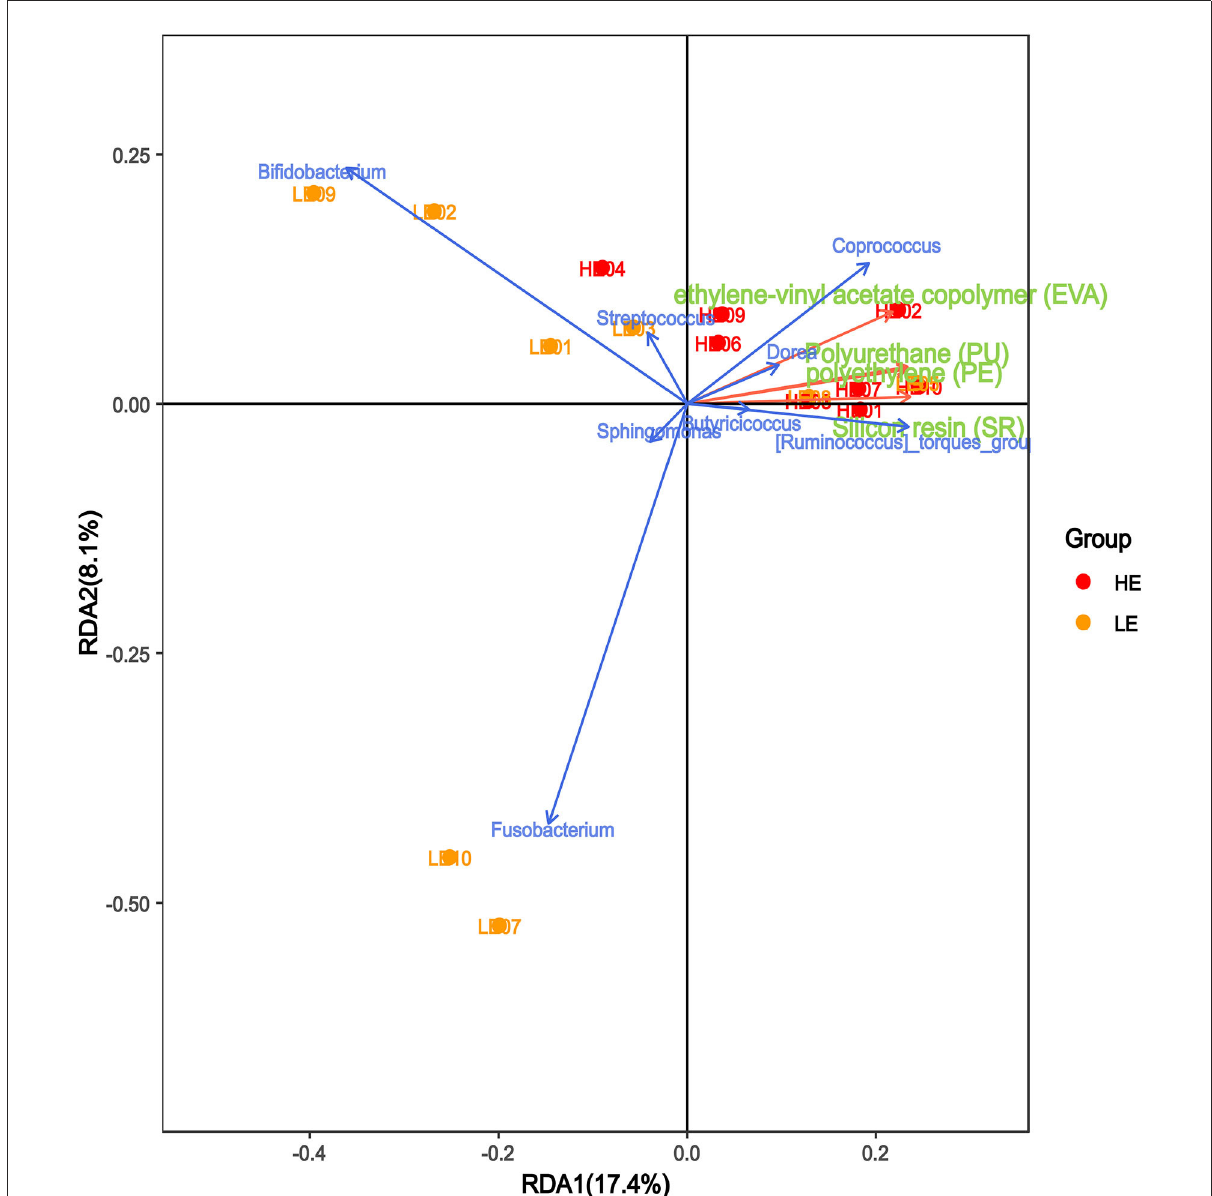
FIGURE6 Correlation analysis of microplastics and microbiota in intestinal secretions. The red arrows in the figure represent different microplastic components, and the blue arrows represent different flora. The angle between the flora and microplastic components represents the positive and negative correlation between the two. Acute angles, positive correlation; obtuse angles, negative correlation; right angles, no